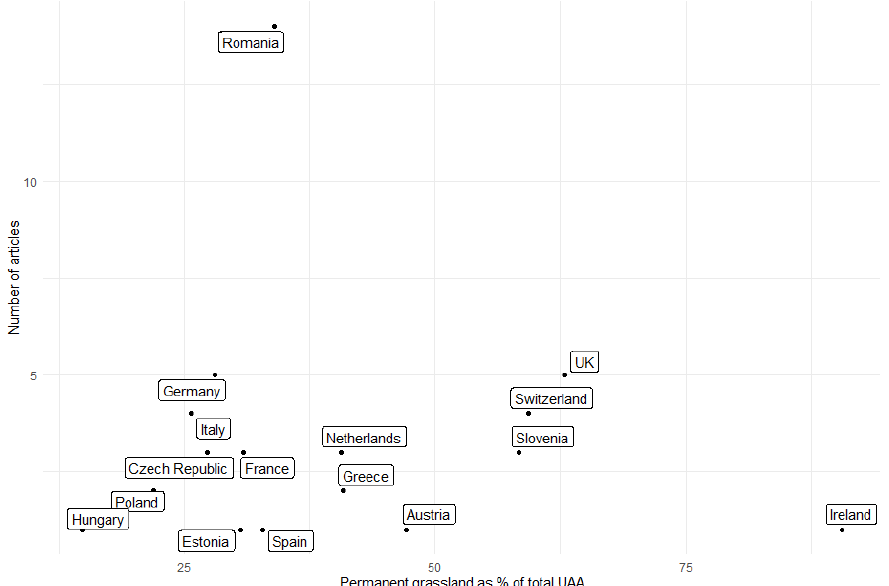
Figure A4. Relationship between number of included articles and the share of UAA consisting of permanent grassland in 16 countries from which the 52 included articles were conducted. There was no significant relationship (see text). Table A1. Number of included articles that contained contrasts of nitrogen fertilisation and defoliation rates.